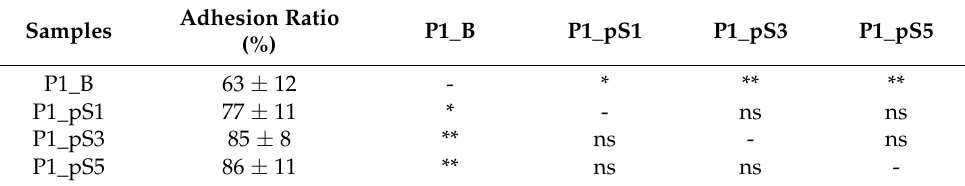
Table 6. Relative cell proliferation calculated as the average of the absorbance in each experimental well, normalized to the average of the absorbance of cell control wells, using day 1 cell population data. Cell proliferation ratios during the initial days of culture calculated as the ratio between cell population on day 4 and on day 1 (PR 1–4) and on days 7 and 1 (PR 1–7). Proliferation rate uncer- tainty is the combined standard uncertainty.